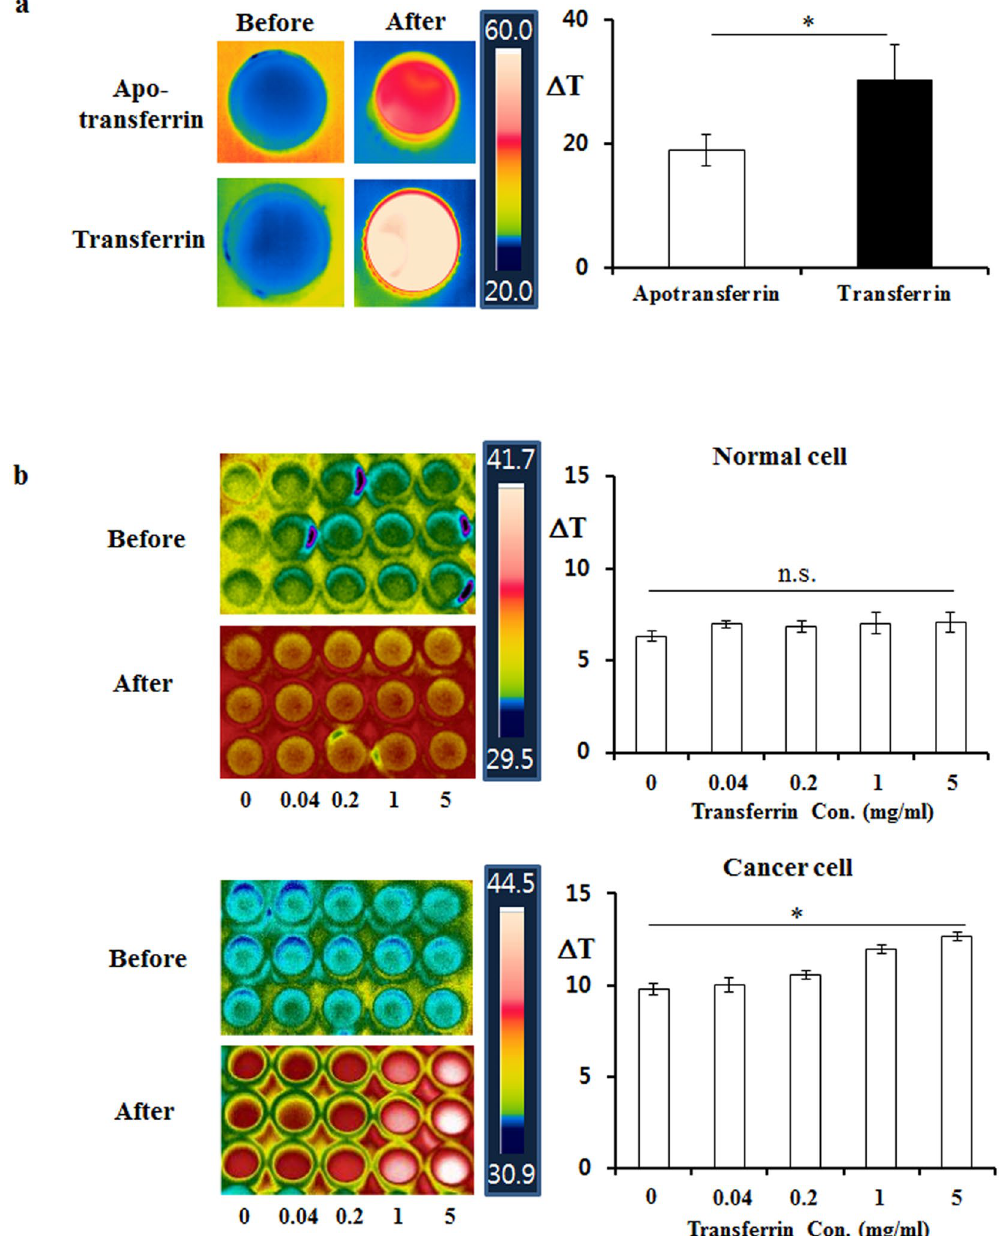
Figure 1. Ferric ion-containing transferrin induced dielectric heat in the 13.56 MHz radiofrequency wave to boost temperature elevation in vitro . ( a ) Either apotransferrin or transferrin solutions of the indicated amount were irradiated by the same amount of 13.56 MHz radiofrequency wave under the same condition, and temperature changes were indicated. The temperature was recorded by FLIR thermal camera before and after 13.56 MHz radiofrequency hyperthermia and temperature change ( Δ T) was calculated. The transferrin solution containing ferric ion showed significant temperature elevation compared to apotransferrin solution without ferric ion. ( b ) Exposure of human lung cancer NCI-H460 cells to transferrin boosted temperature elevation in a dose dependent manner while this effect was not observed in normal primary cells. The values represent the mean ± standard deviation ( n = 6). A paired Student’s t-test was used for the statistical analysis; * p <